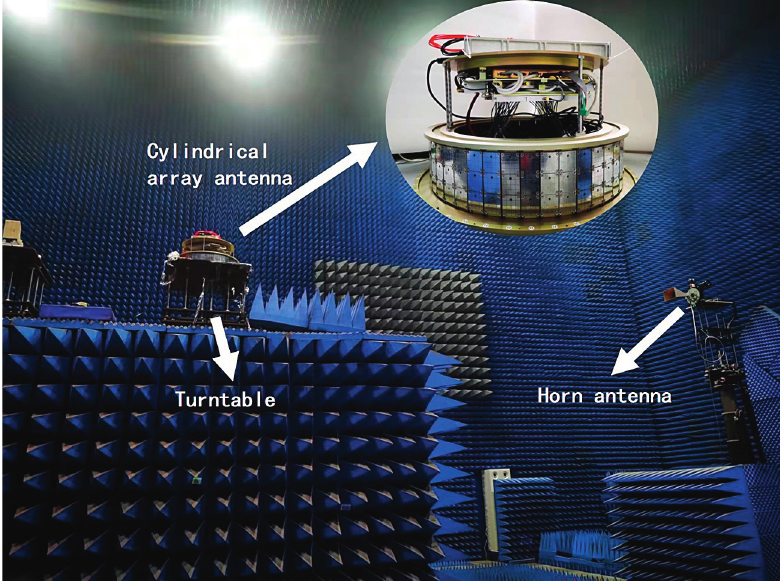
Figure 8: The pattern of cylindrical array antenna was tested in microwave anechoic chamber. There are 3 × 48 antenna units in the array and some hardware modules are exposed outside while in the preliminary debugging stage.